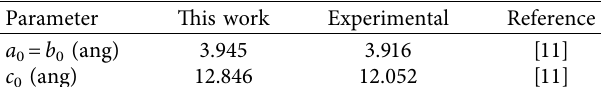
Table 1: Experimental and calculated structural values. Parameter